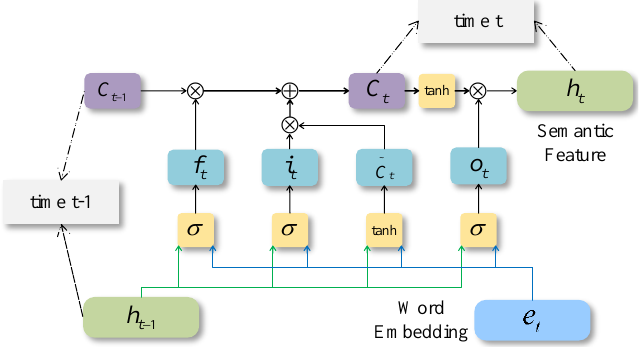
Figure 6. The calculation of a LSTM